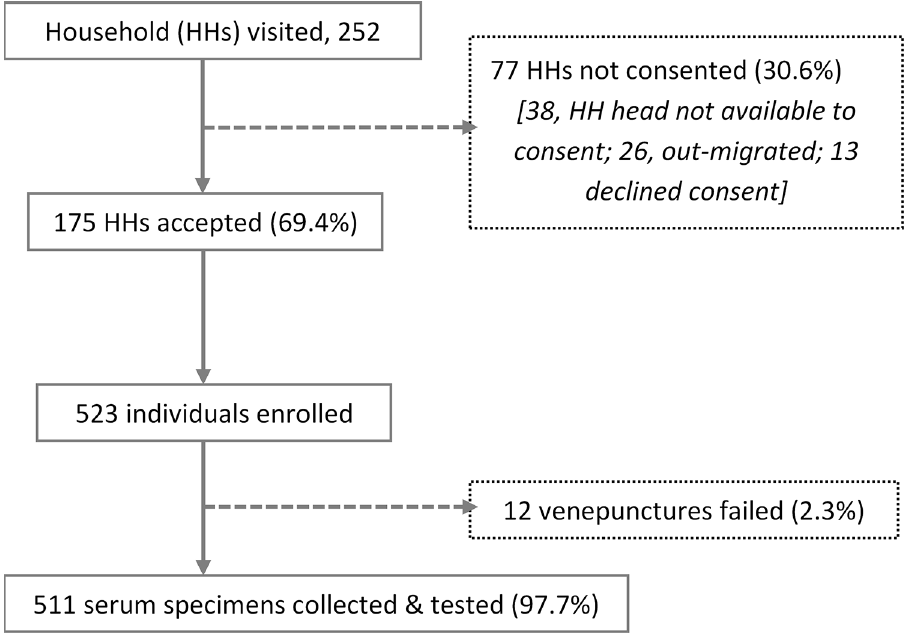
Figure 3. Flow chart showing recruitment process of study household (HHs) and individuals and specimen